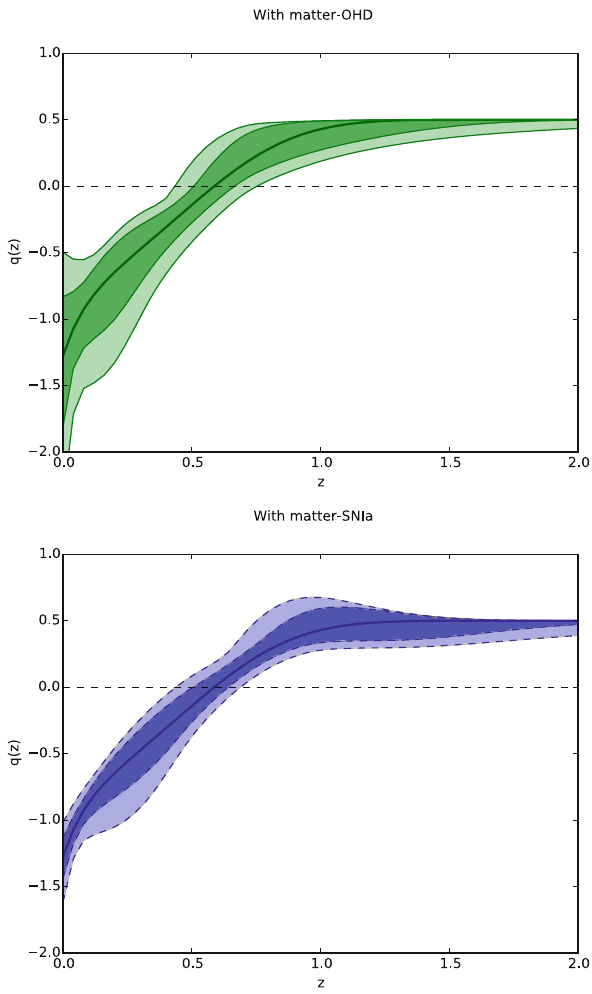
Fig. 14 The top and bottom panels show the reconstruction of the deceleration parameter q ( z ) using using the (cid:19) m 0 , h , h 0 , and b 0 mean values from OHD and SNIa data respectively into the theoretical q ( z ) given by (91). The shadowed areas represent the 1 σ and 2 σ confidence